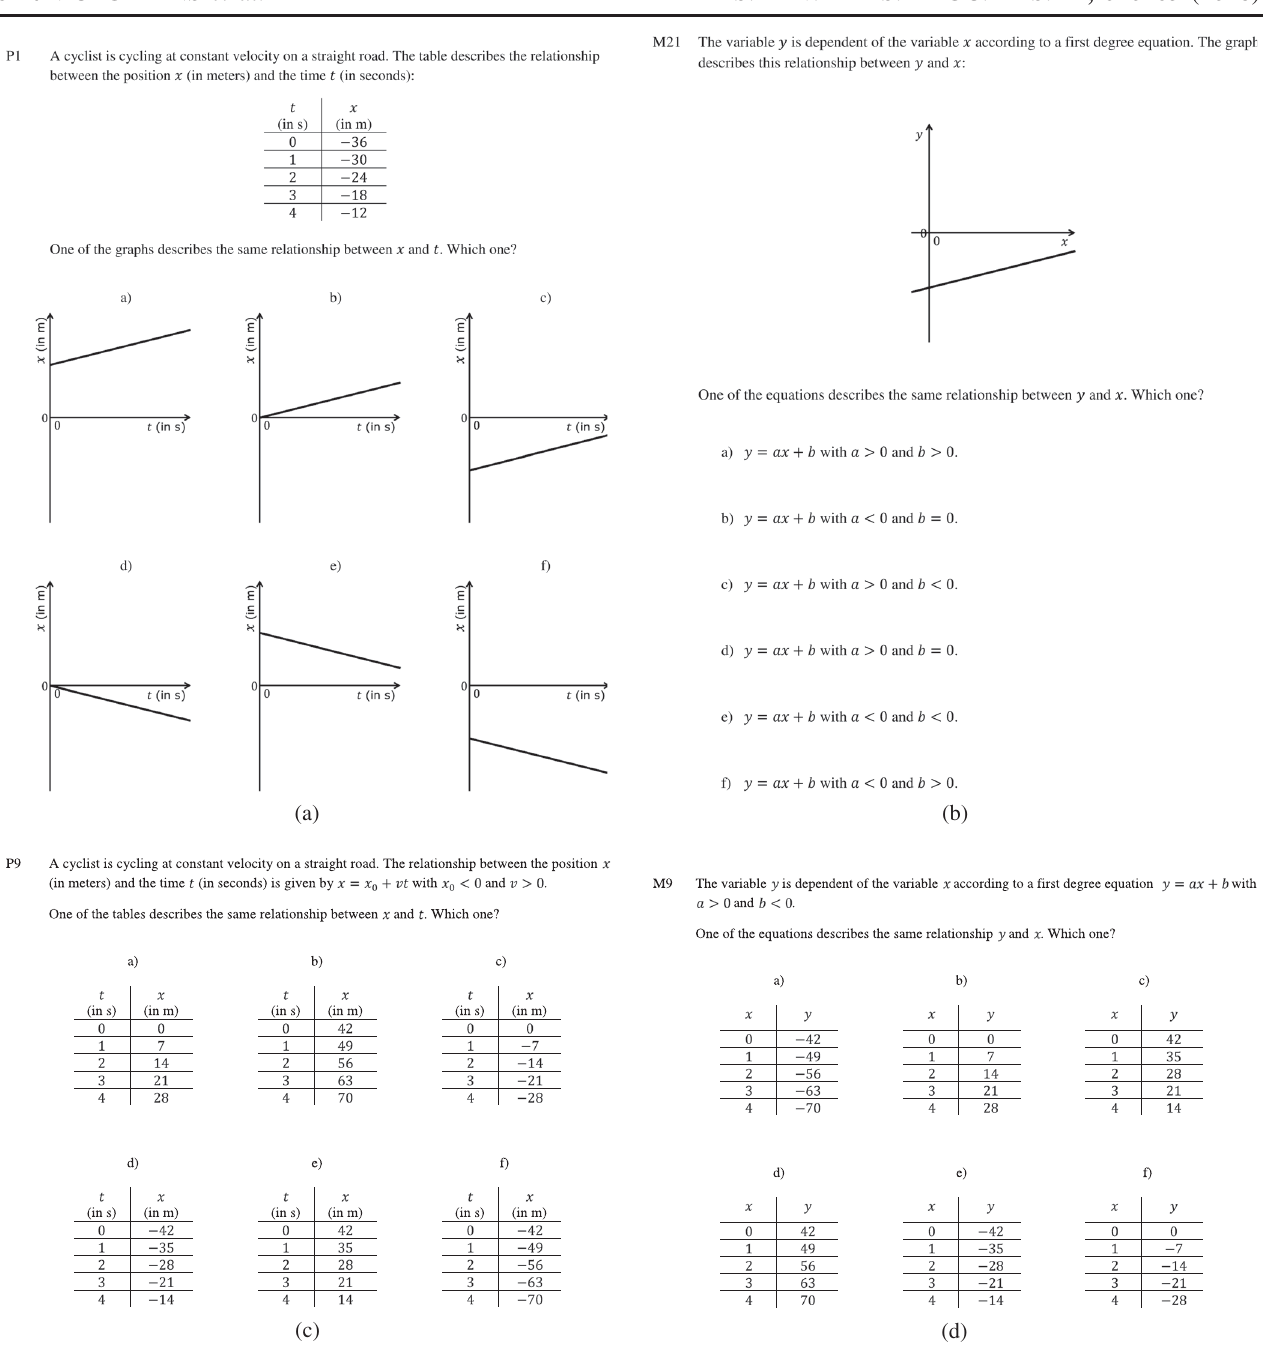
FIG. 2. Example questions from the test. Question P1 is a physics question in which the TG transition from table to graph has to be made. Question M21 is in the context of mathematics and requires a GF transition from graph to formula. Question P9 and M9 are isomorphic questions concerning the formula to table (FT) transition in the context of physics and mathematics,